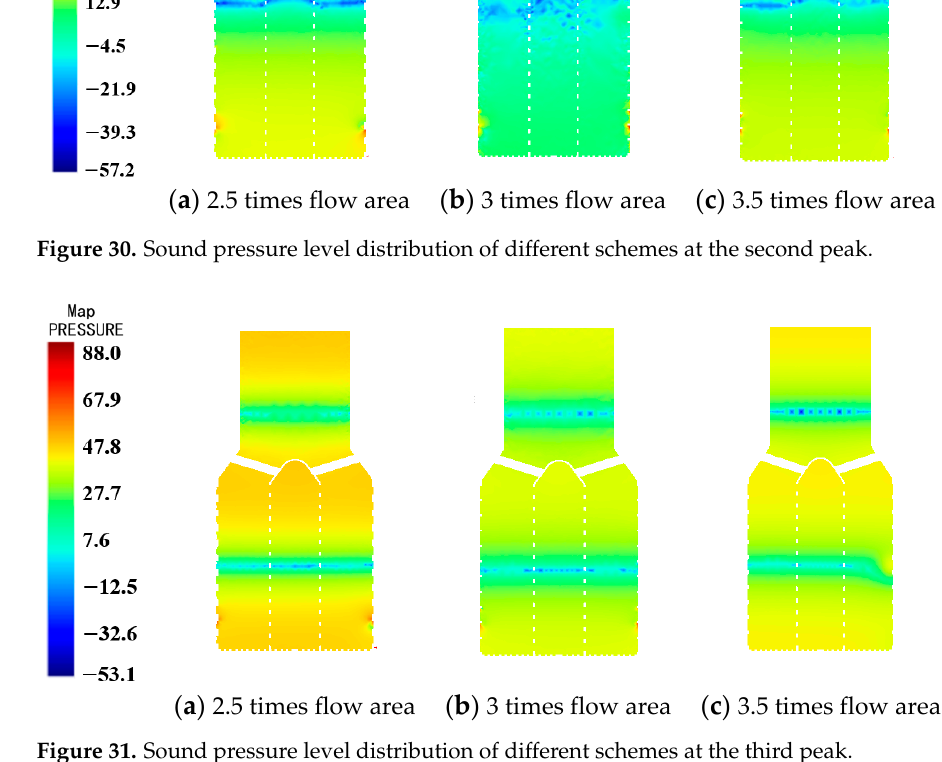
Figure 31. Sound pressure level distribution of different schemes at the third peak.